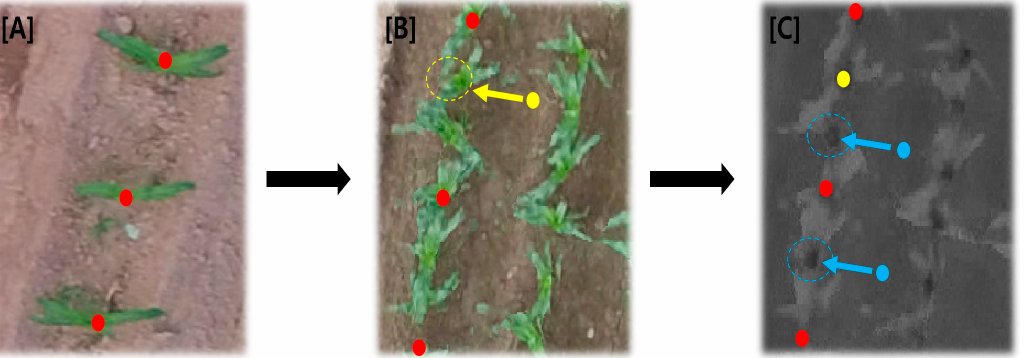
Figure 3. Steps for placing the point data where the sweetcorn existed: ( A ) create the points (red) for the sweetcorn locations in the early germination; ( B ) add the points (yellow) for the late-germinated sweetcorn by comparing with the former RGB images; ( C ) adds the points (blue) for the late-germinated sweetcorn using the RGB values when it is difficult to identify in the RGB pictures.